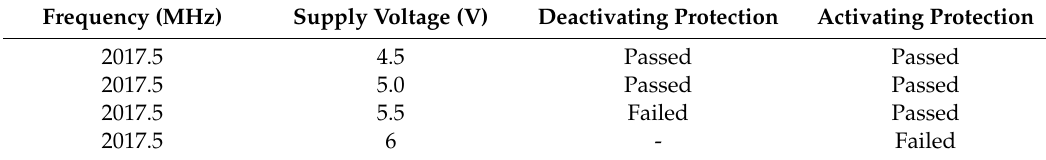
Table 2. Measured ruggedness comparison. ( | Γ L | =